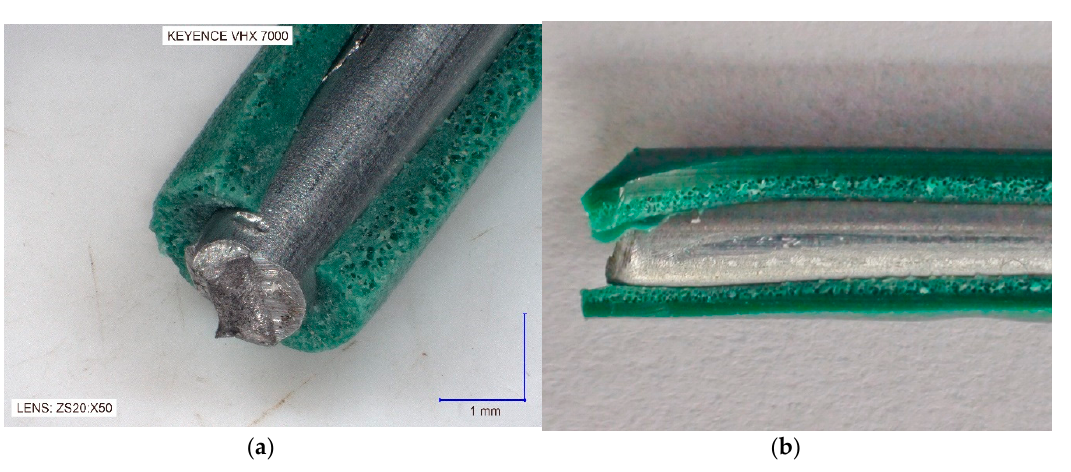
Figure 2. Fragment of the longitudinal section of the metallic wire with PVC cellular coating: ( a ) Single coating; ( b ) Double coating.